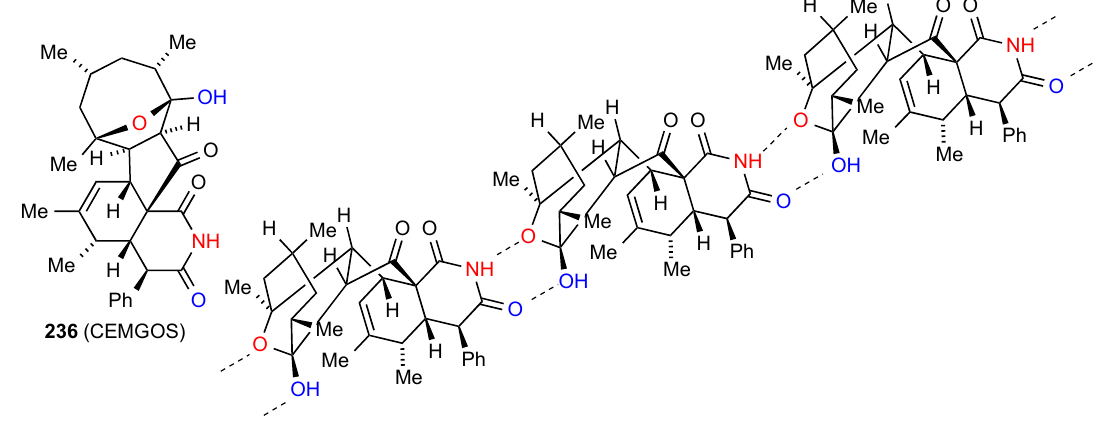
Figure 71. Structure adopted by compound 236.